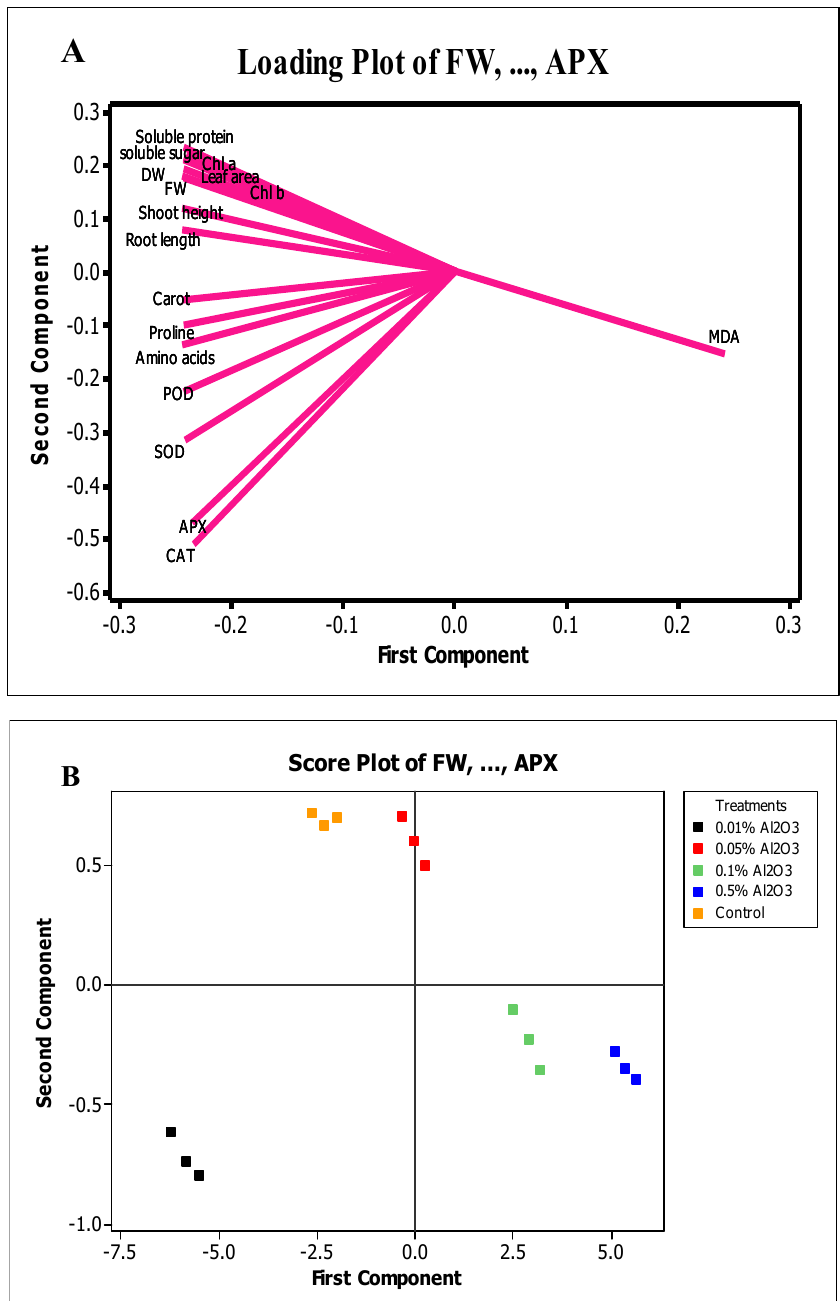
Figure 7. ( A ). Principal component analysis (PCA) to understand the variability relationships of parameters and treatments in roselle plants. The entire dataset was analyzed using a PCA clustering approach. The parameters included FW (fresh weight), DW (dry weight), root length, shoot height, leaf area, Chl a (chlorophyll a), Chl b (chlorophyll b), Carot (carotenoids), soluble sugars, protein, total free amino acids, proline, MDA (malondialdehyde), SOD (superoxide dismutase), CAT (catalase), APX (ascorbate peroxidase), and POD (peroxidase). ( B ) The treatments’ rectangles in different colors included (control) set was primed with distilled water for 12 h. The 2nd set was primed with 0.01% Al 2 O 3 NPs for 12 h. The 3rd set was primed with 0.05% Al 2 O 3 NPs for 12 h. The 4th set was primed with 0.1% Al 2 O 3 NPs for 12 h. The 5th set was primed with 0.5% Al 2 O 3 NPs for 12 h.